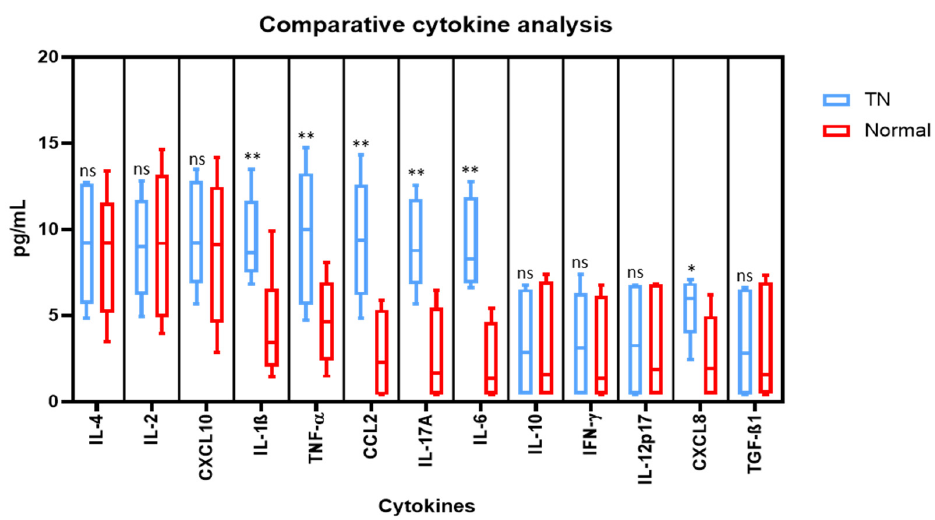
Figure 3. Comparative analysis of cytokines in the saliva of subjects with and without trigeminal neuralgia by cytometric bead array on a flow cytometer. * p < 0.05, ** p < 0.01. IL-4: Interleukin 4, IL-2: Interleukin 2, CXCL10: C-X-C motif chemokine ligand 10, IL-1 β : Interleukin 1 beta, TNF- α : Tumour